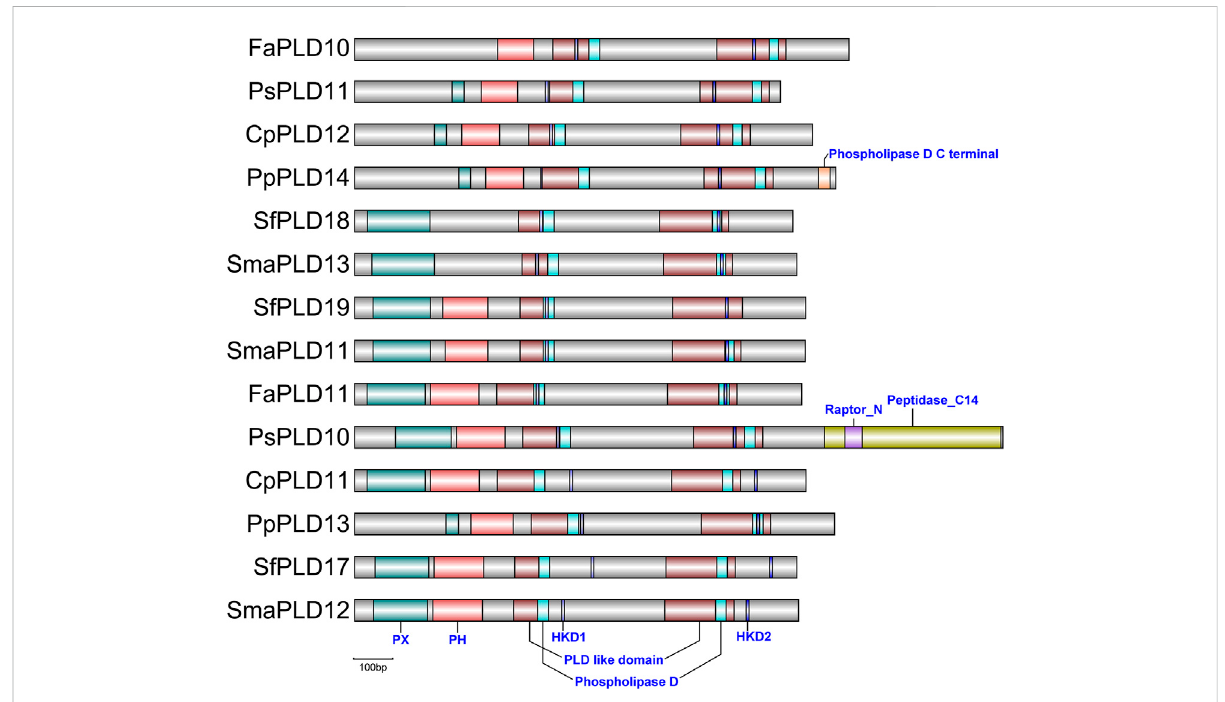
FIGURE 4 Conserved domains and motifs observed in moss clade III (PX/PH) PLDs. The full conserved domains and motifs detected in all PLDs were displayed inSupplementary Table S2due to pagelimitation. The PLDs are ordered according to thephylogenetic tree displayed inFigure 3. The grey bars indicate the PLD protein sequences. The phospholipase D (Pfam accession number: PF00614) and PLD like domains (Pfam accession number: PF13091/PF13918) are indispensable for hydrolyzing phosphatidylcholine into phosphatidic acid. The phospholipase D C terminal (Pfam accession number: PF12357) can bind to calcium. The PX domain (Pfam accession number: PF00787) contains a pbox consensus sequence. The PH (Pfam accession number: PF00169) is a pleckstrin homology domain approximately 120 amino acids in length. The HKD1 and HKD2 motifs contain the core sequence “ H×K××××D ”